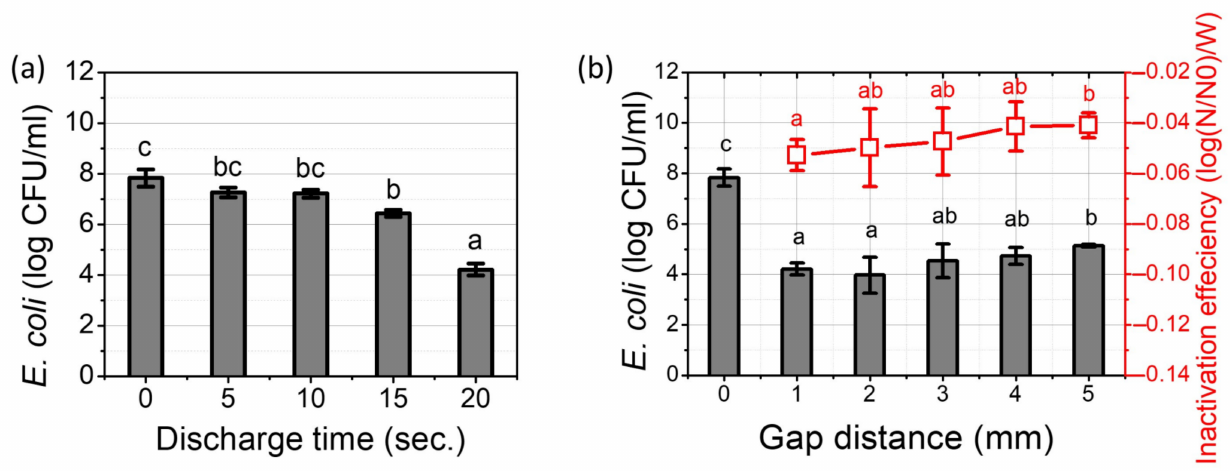
Figure 3. Surviving population (log (CFU)/mL) of E. coli after different treatment conditions; ( a ) different plasma treatment times (0, 5, 10, 15 and 20 s) with a 1-mm gap distance; ( b ) differ- ent gap distances with a 20-s treatment time (gray bars), and inactivation of the E. coli population per input power in watt (red dots). Results are presented as the mean ± standard deviation from three independent experiments. Different letters indicate significant differences ( p <